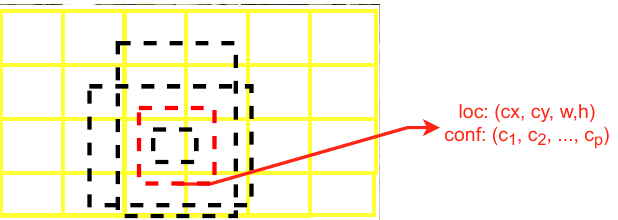
Figure 3. Anchor box shapes used in the SSD architecture. Adapted with permission from ref.